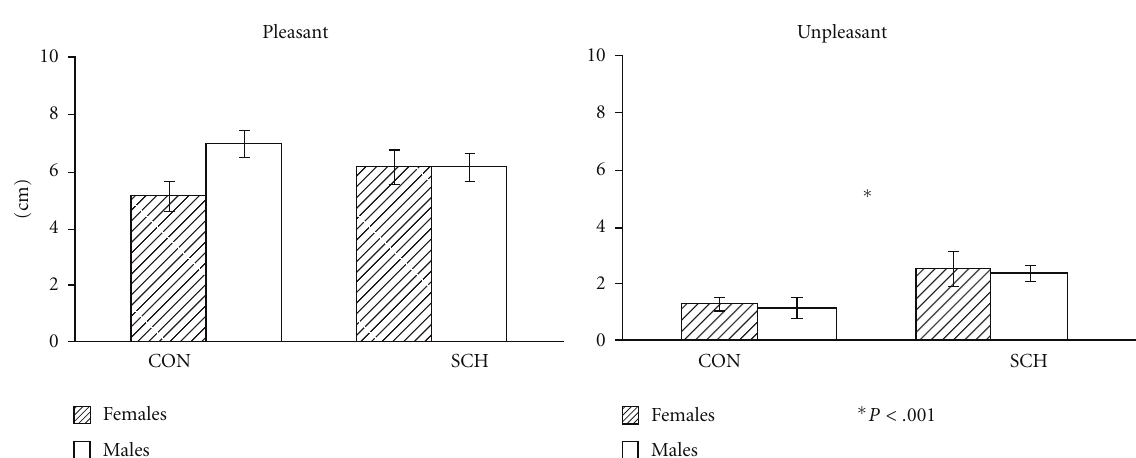
Figure 1: Means and standard errors on the pleasant and unpleasant A ff ective States Scale in controls (CON) and schizophrenic patients (SCH). SCH group reported higher unpleasant a ff ectivity than CON. Facial recognition Figure 2: Means and standard errors of the percentage of correct responses and response times in the facial emotional recognition tasks for the control (CON) and schizophrenic groups